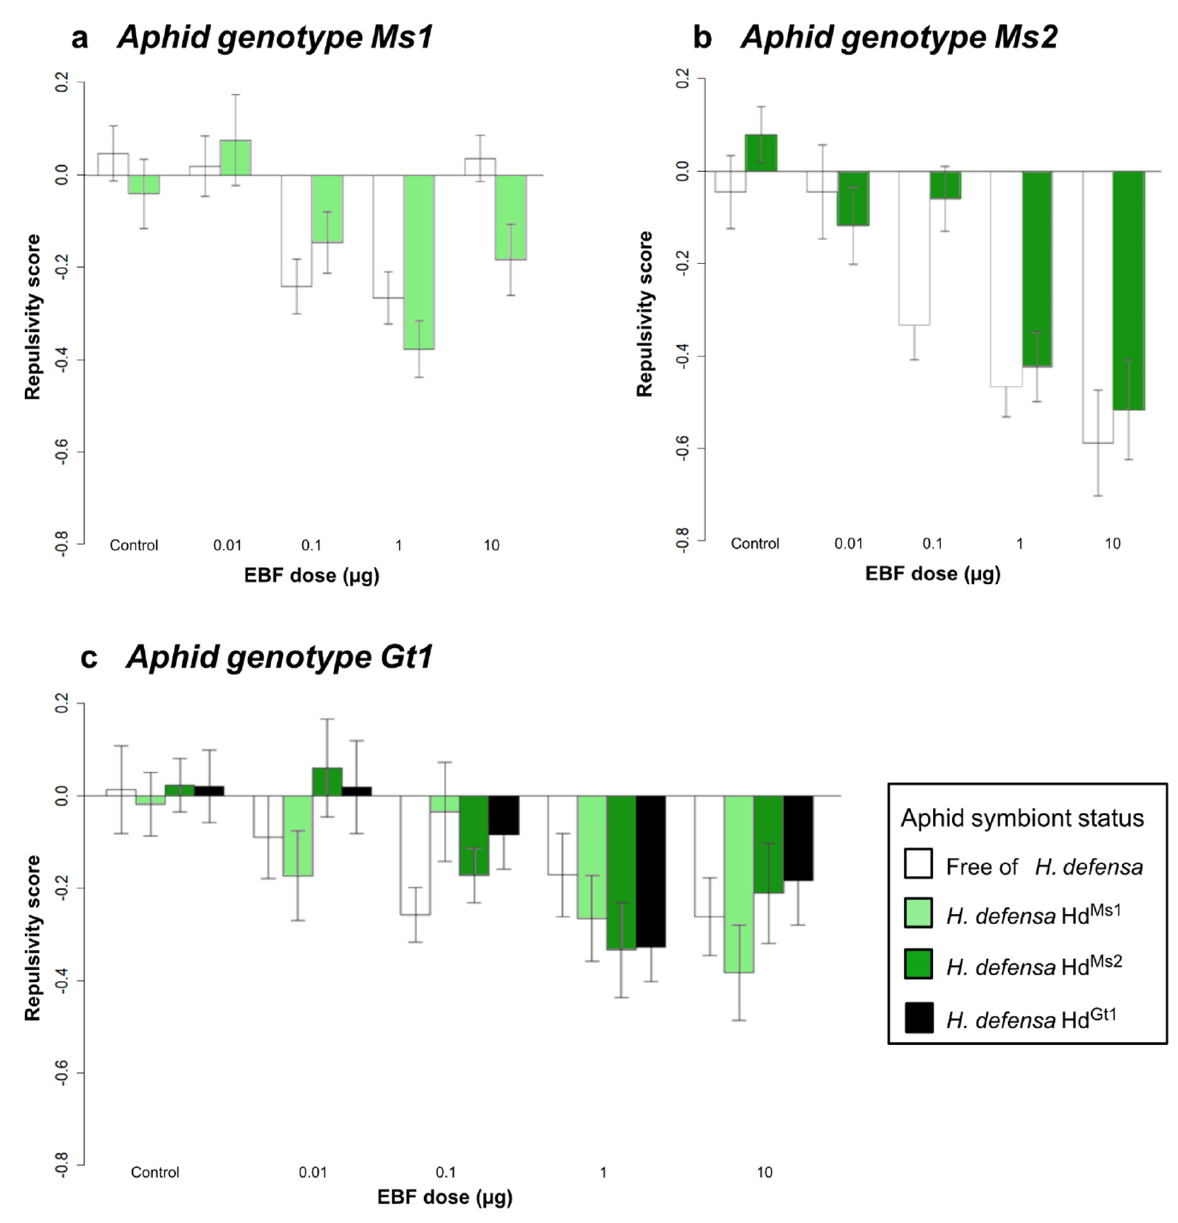
Figure 2. Repulsivity score at different EBF doses in A. pisum genotypes carrying or not carrying Hamiltonella defensa. White bars represent lines without H. defensa , and coloured bars represent lines with H. defensa . Different colours refer to different H. defensa strains. ( a ) Aphid genotype Ms1 (specialised on Medicago sativa ). ( b ) Aphid genotype Ms2 (specialised on M. sativa ). ( c ) Aphid genotype Gt1 (specialised on Genista tinctoria ). Error bars show the standard error. N = 30 aphids for each stimulus and line.